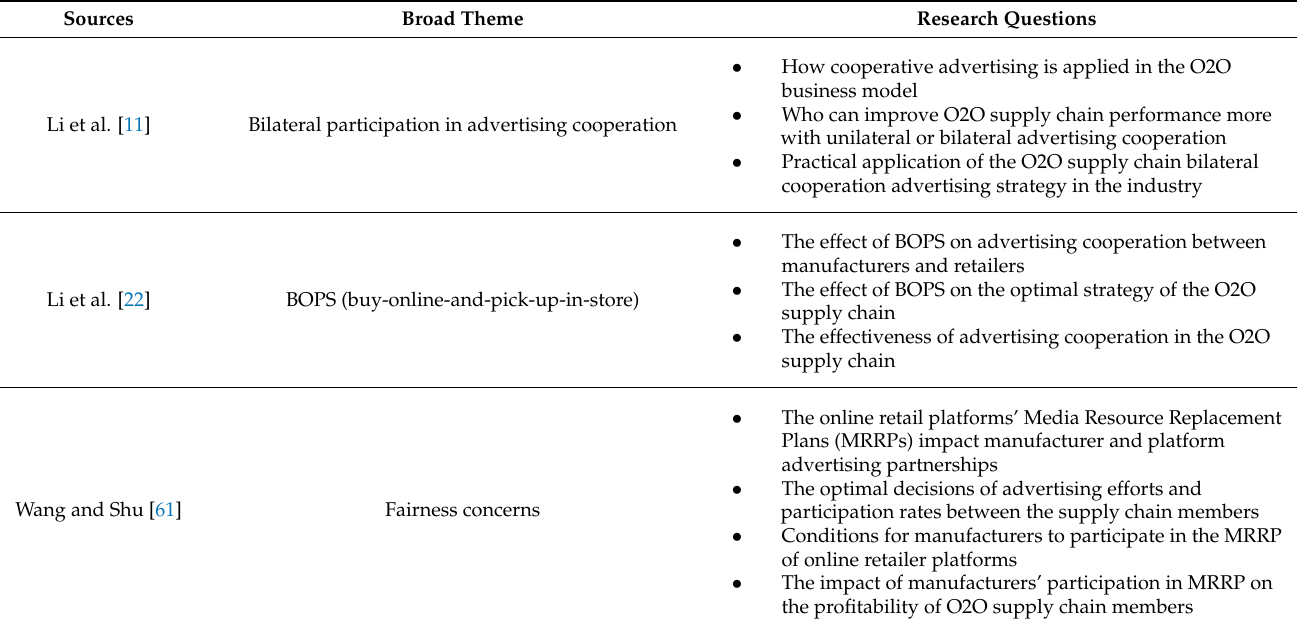
Table 1. Literature related to advertising cooperation in the O2O supply